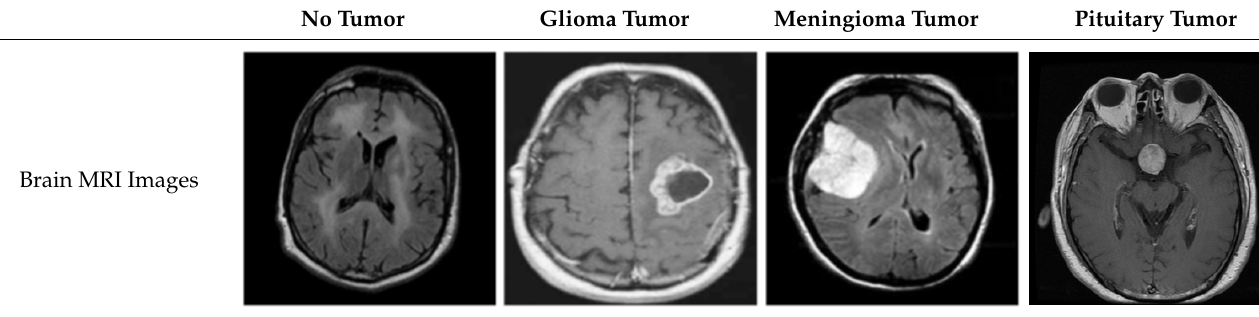
Table 1. Classification of brain MRI images.